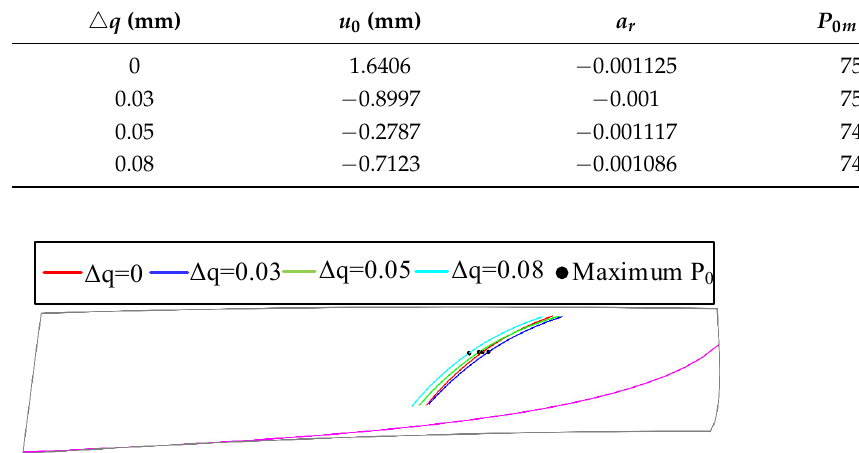
Figure 17. Contact paths for different values of the axial displacement error.